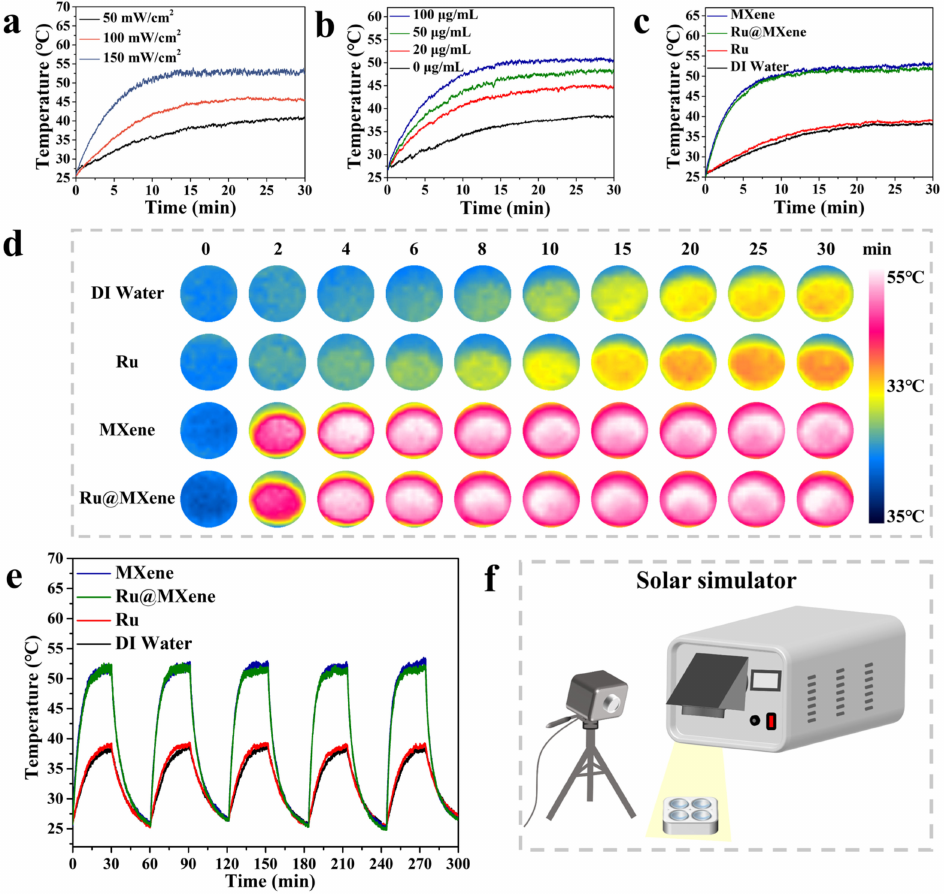
Figure 6. Photothermal property assessments: photothermal heating curve of Ru@MXene ( a ) with gradient concentrations; and ( b ) with different power density. ( c ) Photothermal heating curve of various samples with a power density of 150 mW/cm 2 . ( d ) Real-time infrared thermal images of different samples. ( e ) Photothermal periodic curve of Ru@MXene. ( f ) Schematic diagram of simulated sunlight irradiation